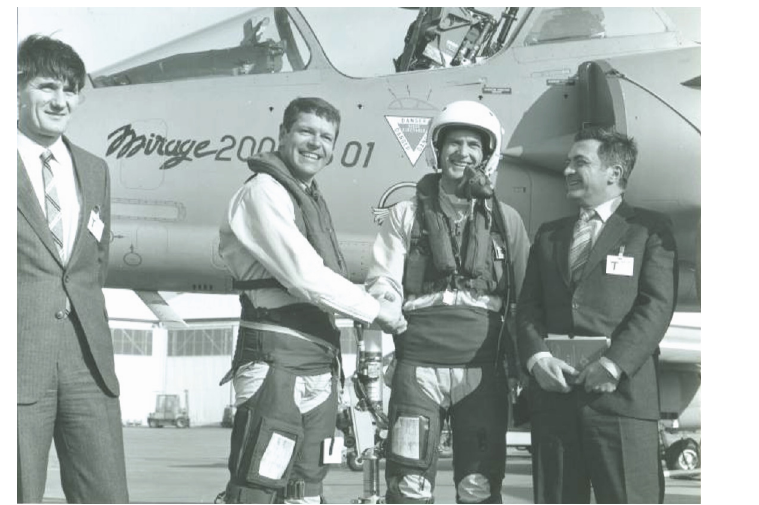
Figure 16 – Test team after a flight (test pilot, Colonel Branko Bilbija, second from the right), French Test Center Istres Marseille, March,